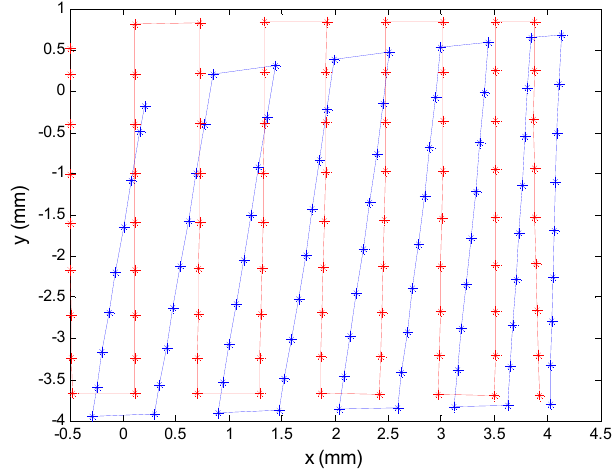
Figure 23. Corrected points (red), varying a resistor by 50% and points detected before correction (blue).